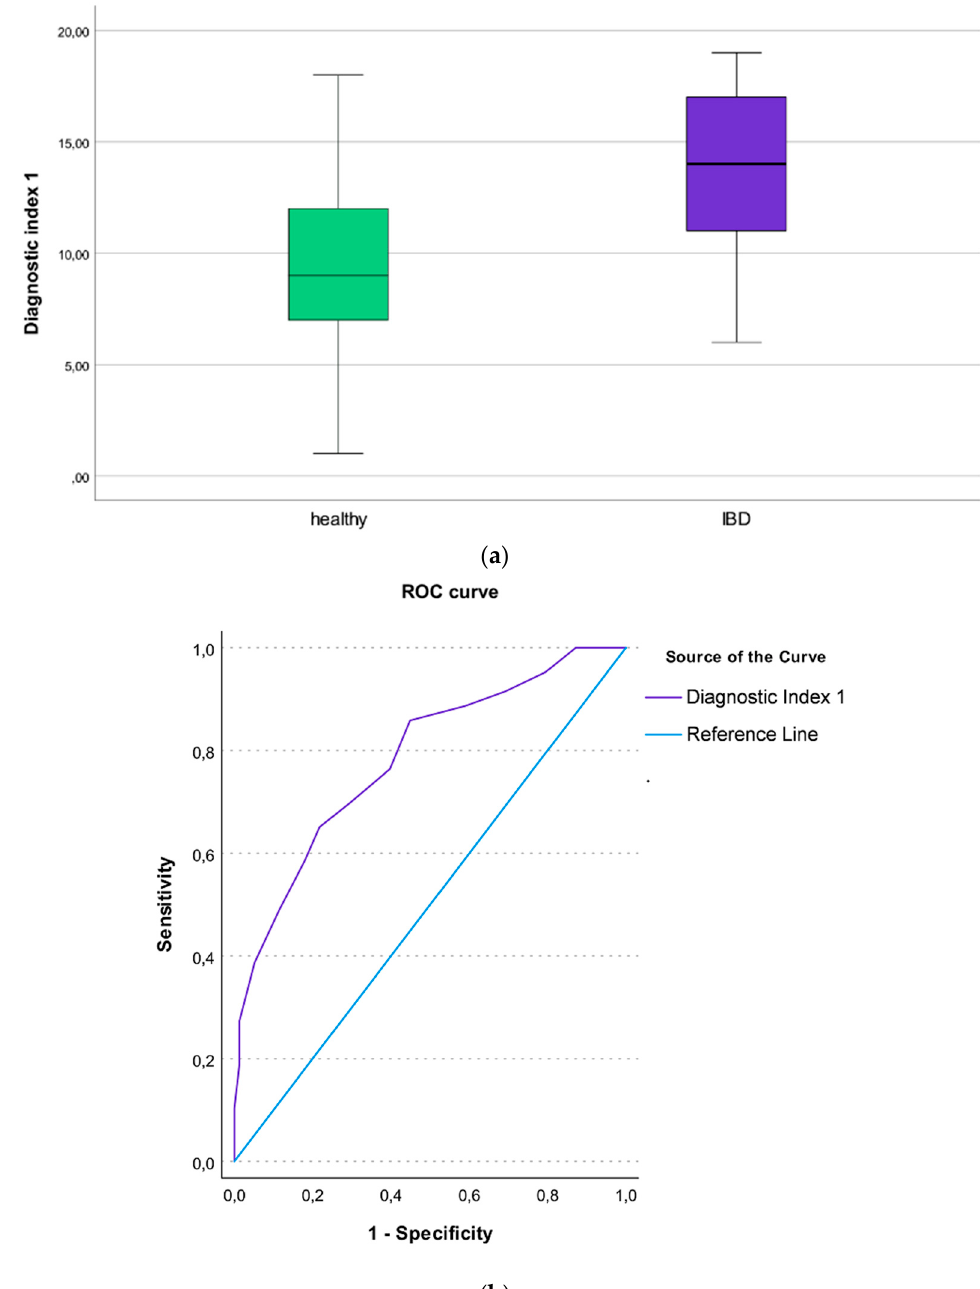
Figure 1. ( a ) Boxplot illustrating the Diagnostic Index 1 differentiating IBD patients from healthy individuals; ( b ) Roc curve showing the AUC of the Diagnostic Index 1 differentiating IBD patients from healthy individuals.